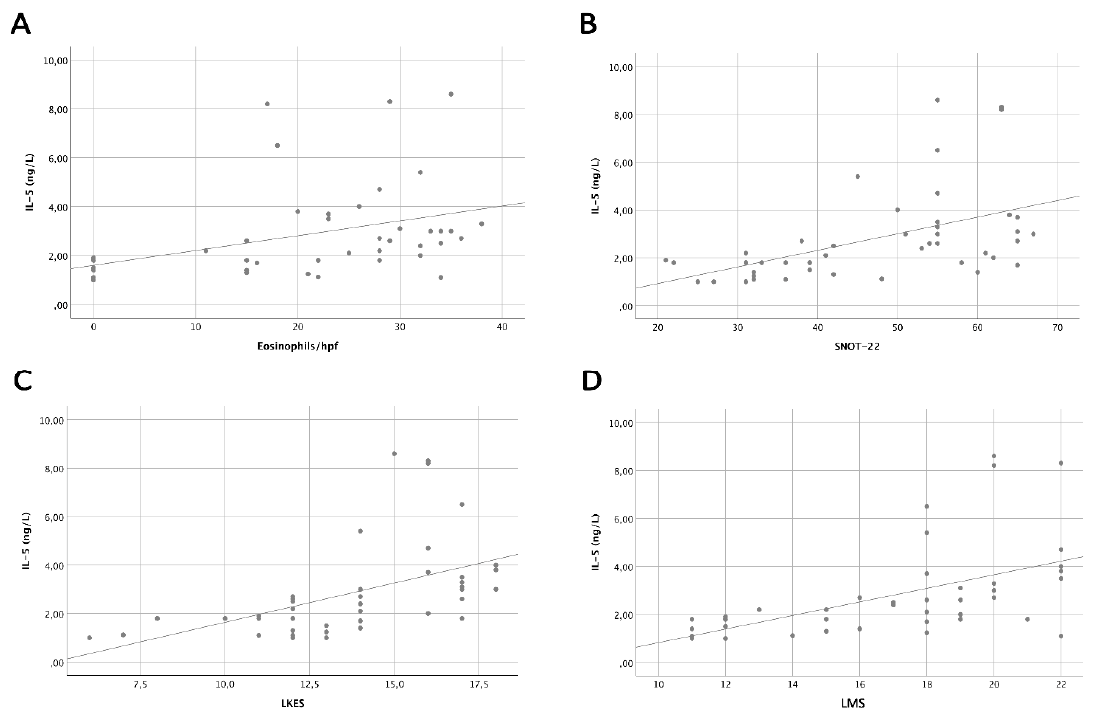
Figure 2. Correlation between IL-5 and main clinical parameters. Scatter plots reporting the results of Spearman’s rank test, with a significant linear correlation between IL-5 levels and eosinophilic count/HPF ( A ), SNOT-22 score ( B ), LKES score ( C ), LMS score ( D ). Abbreviations: hpf = high power field.